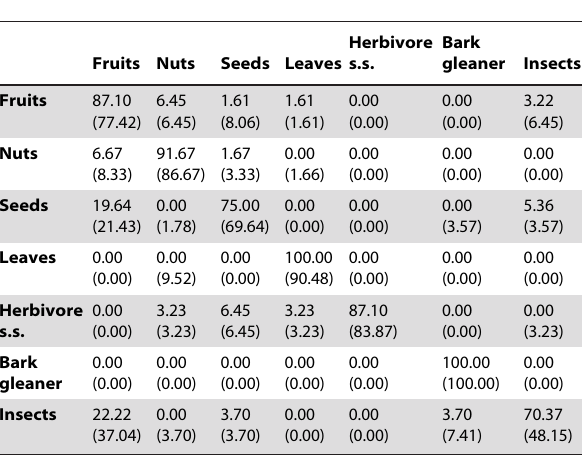
Table 3. Summary of the classification results for the Canonical Variates Analysis (CVA) of squirrel mandible shape using dietary preferences as grouping